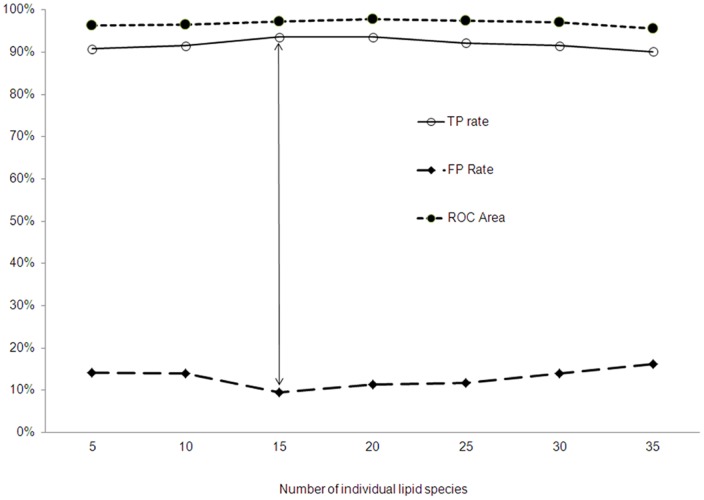
Effect of multiple individual lipid species in diagnosis of prostate cancer.The points indicated by the two head arrows are the predictive powers of top 15 plasma apparent lipid species when they are used together in diagnosis of prostate cancer. Using top 15 plasma apparent lipid species has the highest sensitivity (93.6%), the highest specificity (90.1%), and higher accuracy (ROC Area, 97.3%) in the diagnosis of prostate cancer as compared with using any other combination of different numbers.